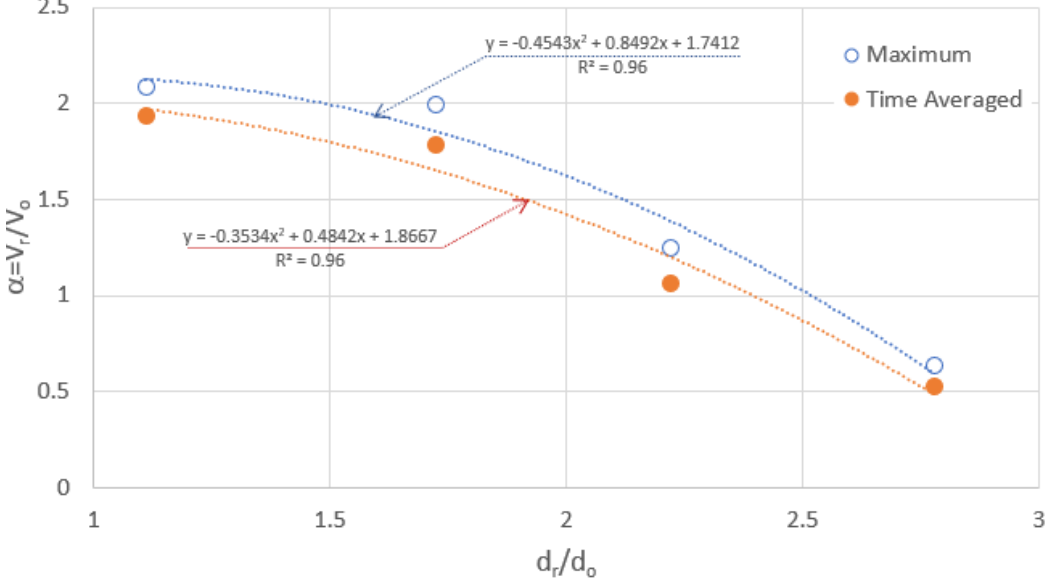
Figure 15. Temporal variation of the tip rotor’s speed ratio (4-blade rotors).